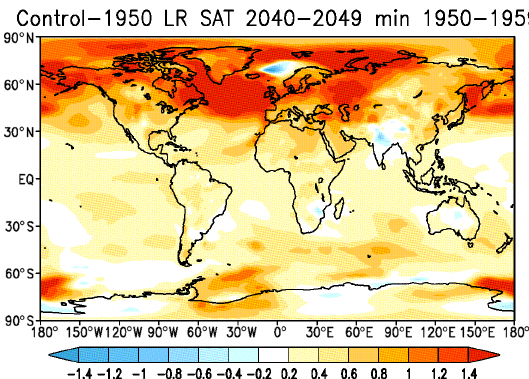
Figure 12. Ensemble mean SAT ( ◦ C) of the averaged last 10 years (2040–2049) minus the averaged first 10 years (1950–1959) of the control-1950 simulations of